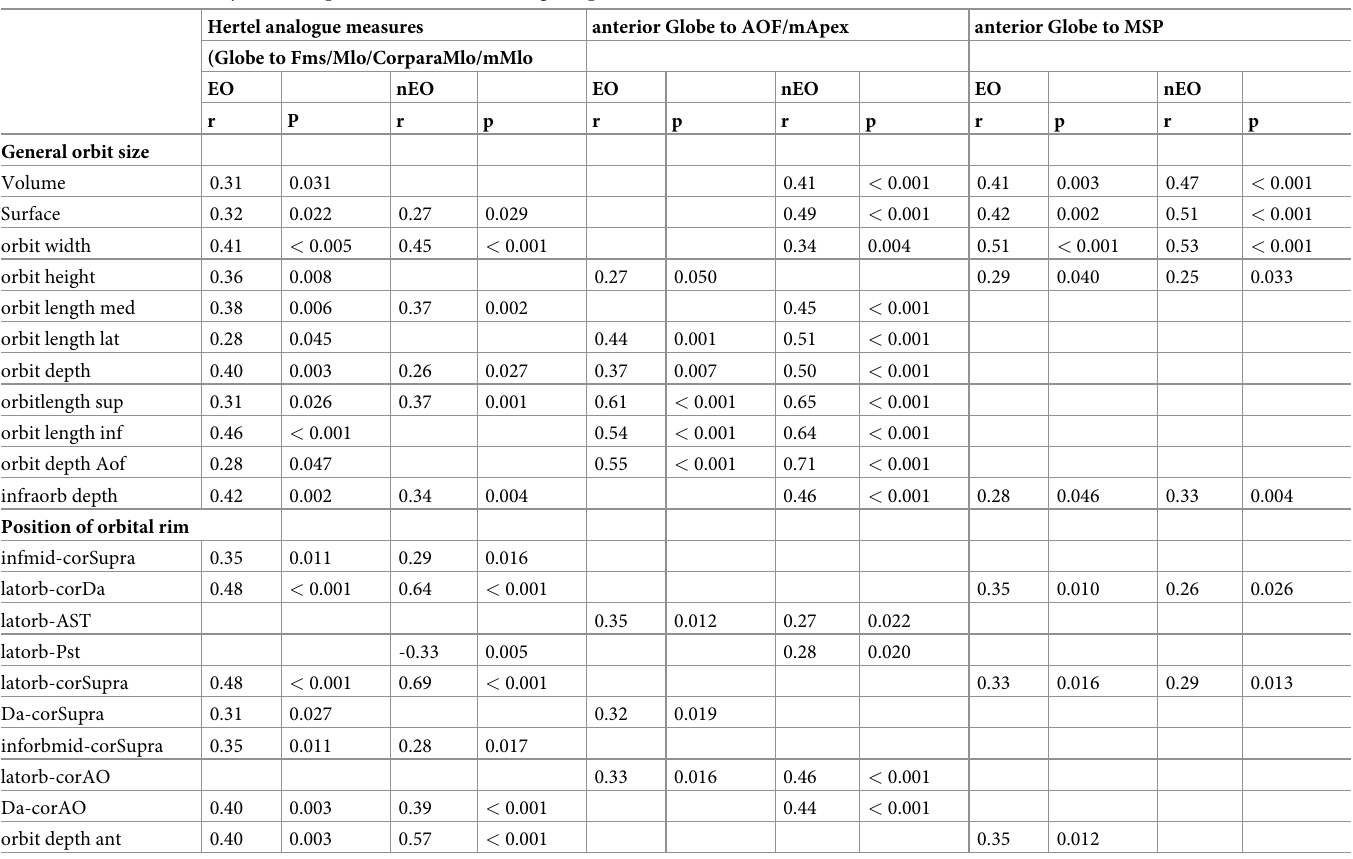
Table 5. Correlation of bony anatomic parameters (distances) to globe position